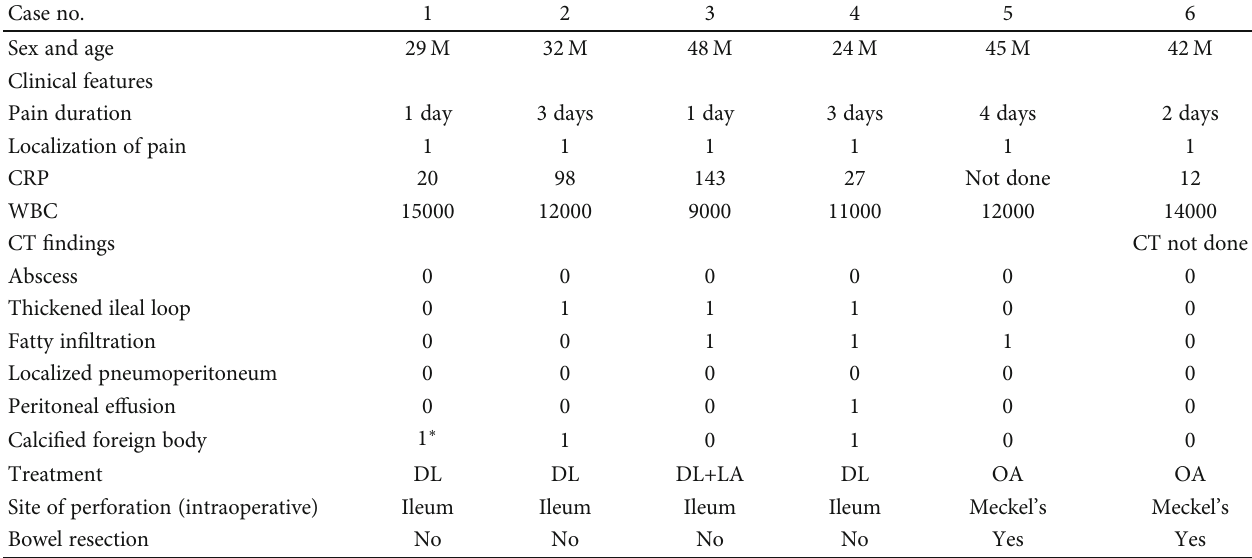
Table 1: Summarizes the presentation of all the cases.